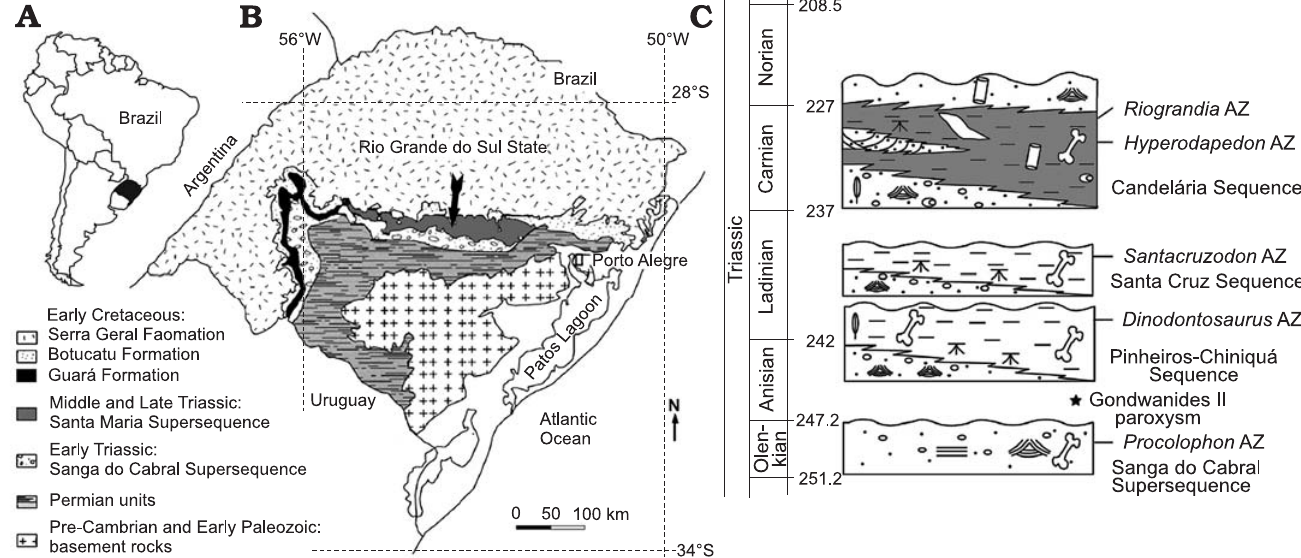
Fig. 1. A . Map of South America with the state of Rio Grande do Sul shaded. B . Location of the Agudo municipality (arrow) in the state of Rio Grande do Sul, where Middle and Upper Triassic rocks crop out. C . Sequence stratigraphy of Brazilian rocks containing Triassic vertebrates, with the Hyperodapedon Assemblage Zone highlighted (modified from Horn et al.